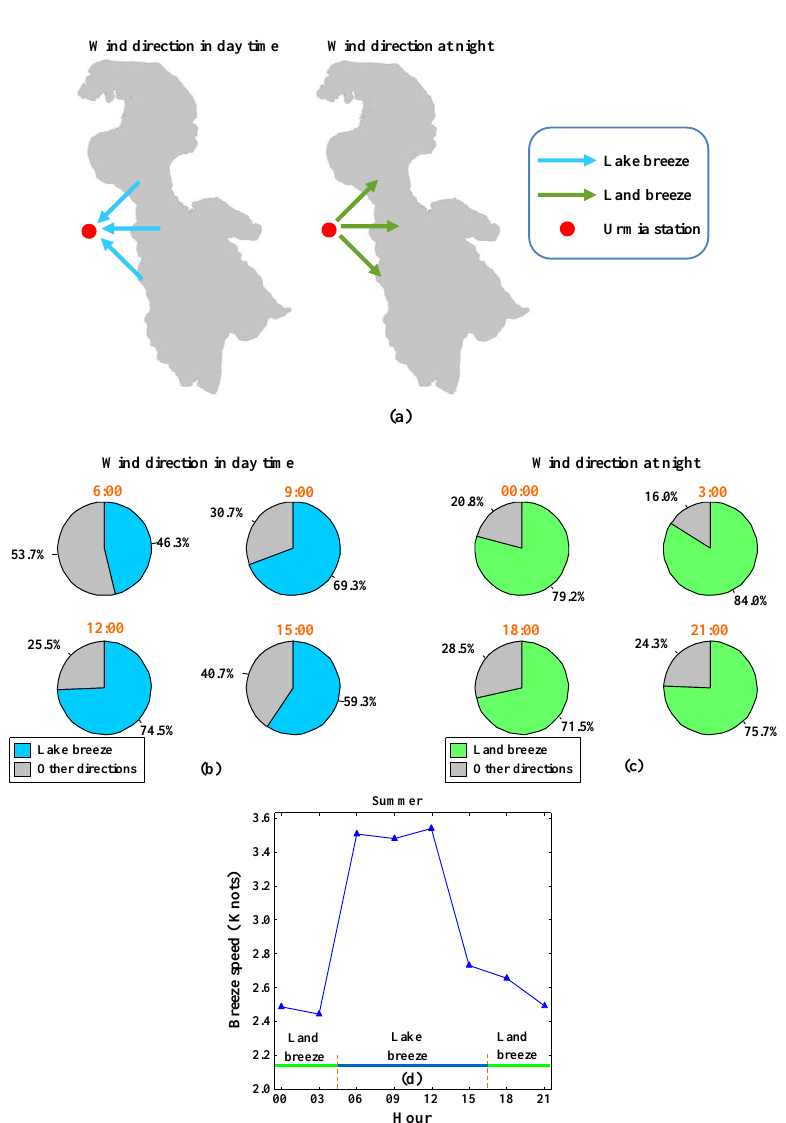
Figure 4. ( a ) Schematic diagram of land / lake breezes direction (inspired by [21]). Hourly wind direction at Urmia meteorological station in summer ( b ) in daytime and ( c ) at night. ( d ) Speed of lake breeze (6:00 to 15:00 h) and land breeze (18:00 to 03:00 h) at Urmia station. Scatterplots and boxplots showing the seasonal pattern in maximum temperature ( T max ), minimum temperature ( T min ), and the difference between maximum and minimum temperature ( T max –T min ) at Urmia and Saqez stations are presented in Figure 5, where average values of the climate variables are shown with black dots in the boxplots. The results showed that the maximum temperature at Urmia station was lower than that at Saqez station during summer, spring, and autumn, but was similar in winter (Figure 5a). The corresponding boxplot for the two stations showed that the mean and median values and range of variation in maximum temperature were all lower at Urmia station than at Saqez station in summer, but that the difference decreased in spring and autumn and practically disappeared in winter (Figure 5b).